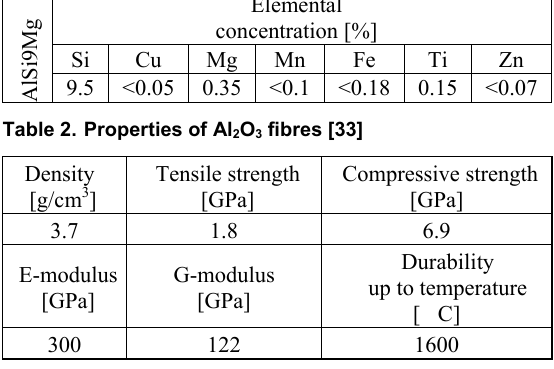
Table 3. Selected properties of tested material [34,